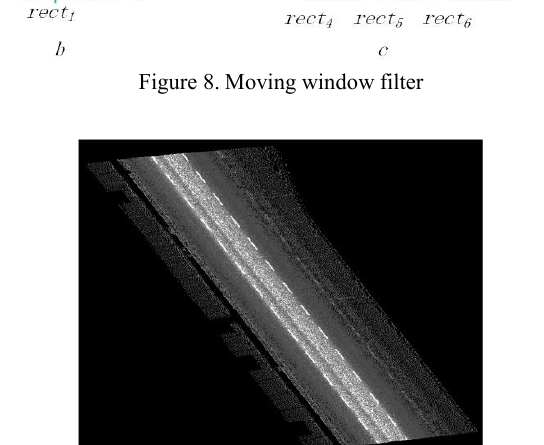
Figure 10. Inverse distance weighted interpolation